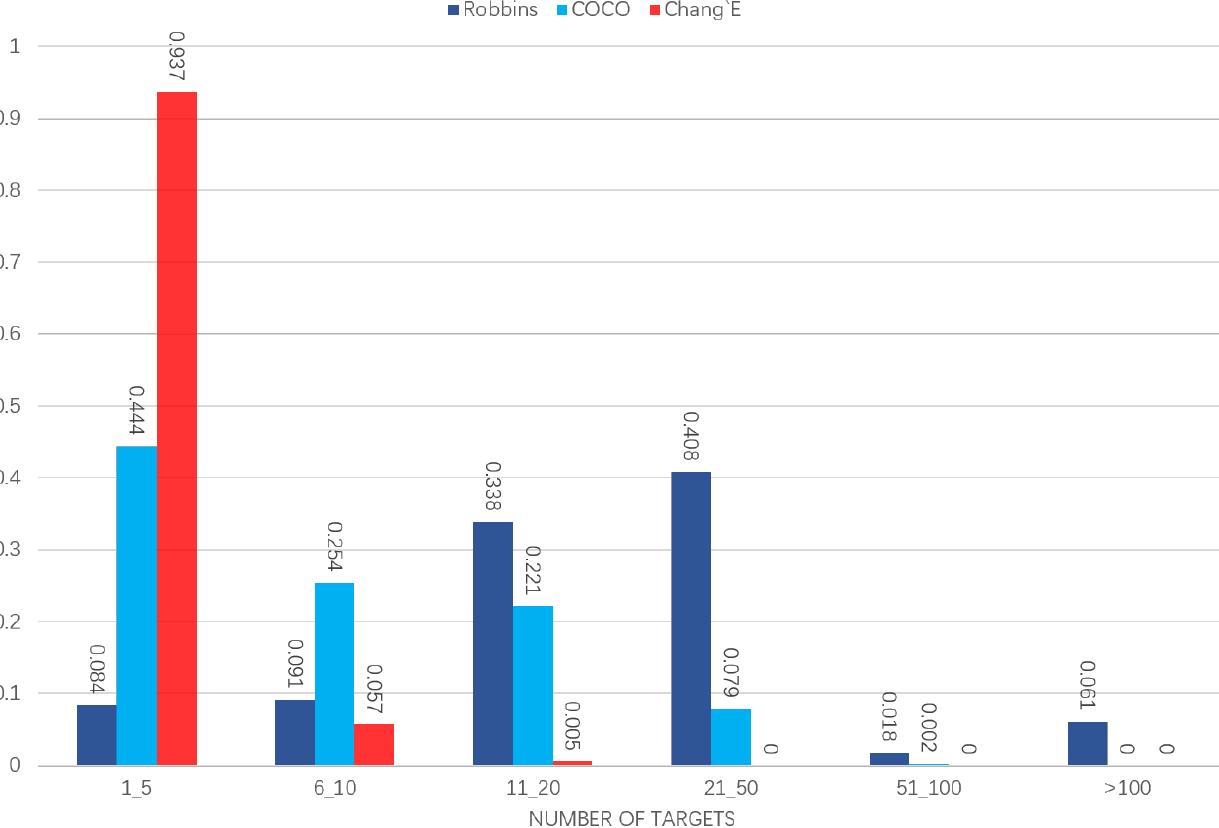
Figure 15. The distribution of the target number in each picture (512 × 512 pixels) on the three datasets. The x-axis represents several different ranges of the number of targets in each picture. The y-axis represents the proportion of the images containing the corresponding number of targets in the total dataset.